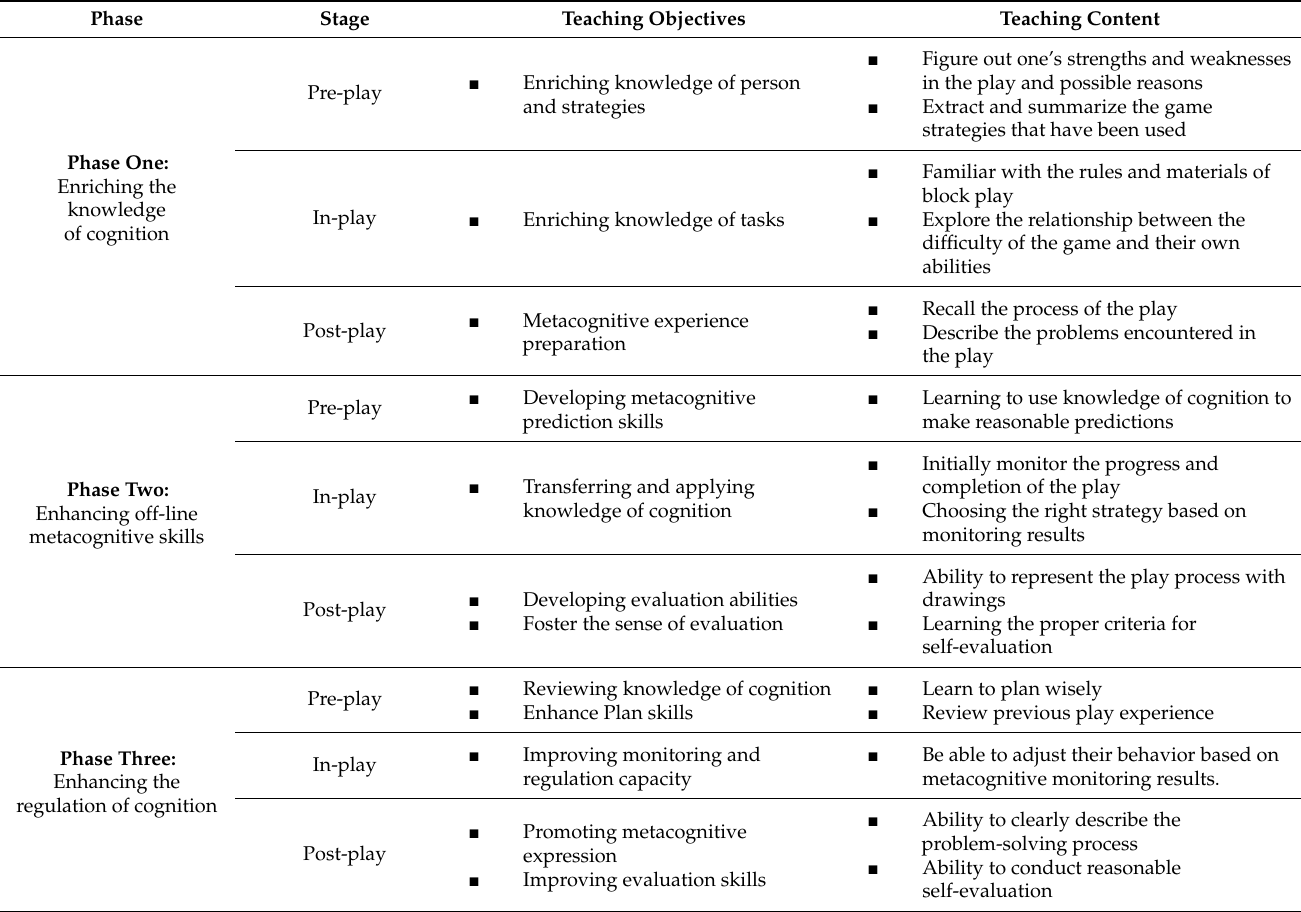
Table A1. The overall structure of the Circling Curriculum for Metacognition